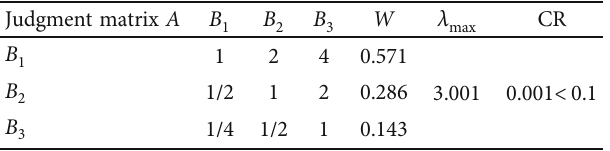
Table 12: Judgment matrix of criterion layer evaluation index.